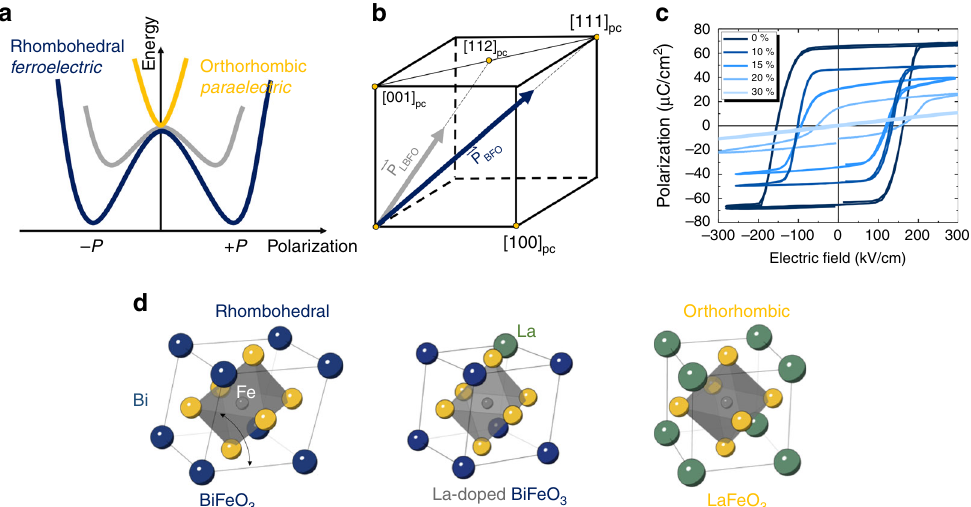
Fig. 1 Ferroelectric ordering in Bi 1 − x La x FeO 3 . a Schematic for the energy landscape of the phase transition induced by lanthanum substitution in BiFeO 3 described by Landau theory. b Schematic for the ferroelectric polarization rotation (from BiFeO 3 : [111] pc to Bi 0.85 La 0.15 FeO 3 : [112] pc ) and suppression of ferroelectric polarization induced by lanthanum substitution in BiFeO 3 . c P-E measurements for different substitution levels of lanthanum in 100-nm-thick BiFeO 3 fi lms. d The schematics illustrate the evolution of crystal symmetry of bismuth ferrite (rhombohedral) to lanthanum ferrite